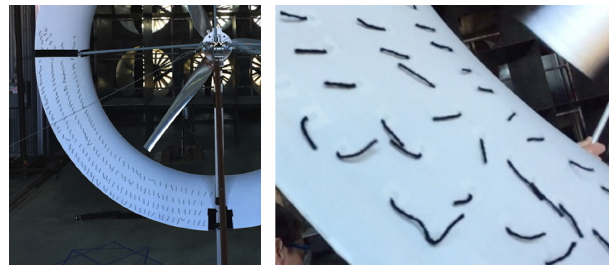
Figure 15. Tufting on the ducted